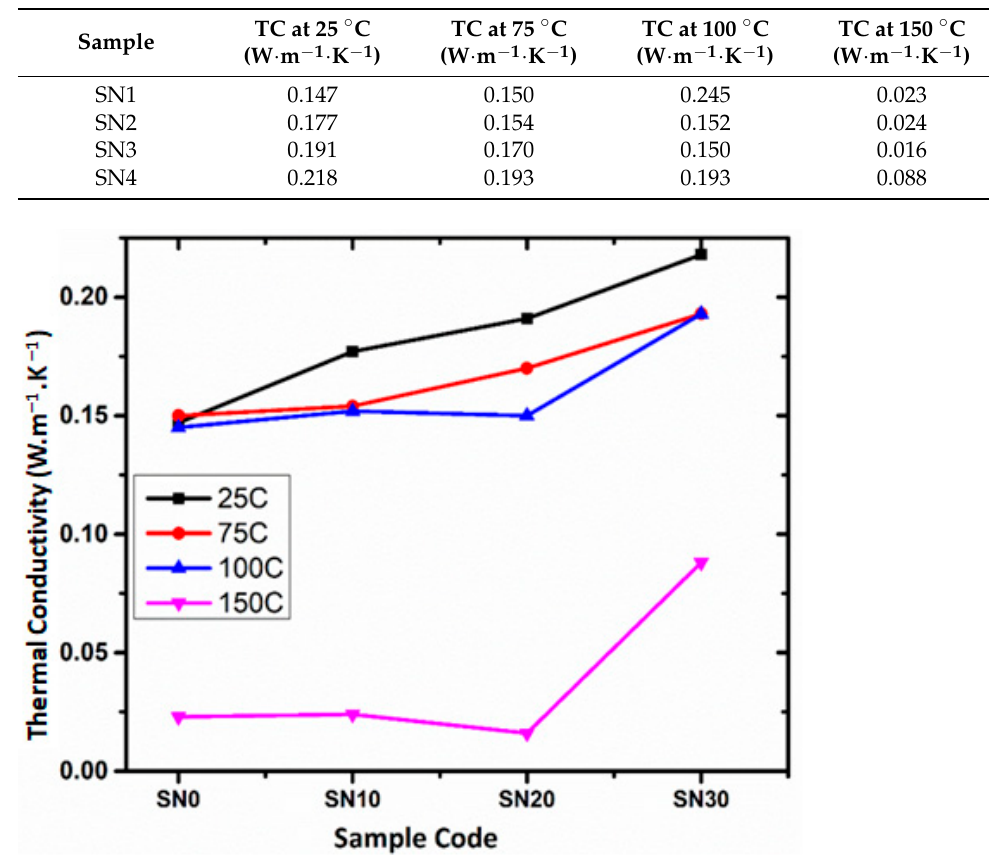
Figure 11. Thermal conductivity (TC) of polystyrene/m-BN composites.